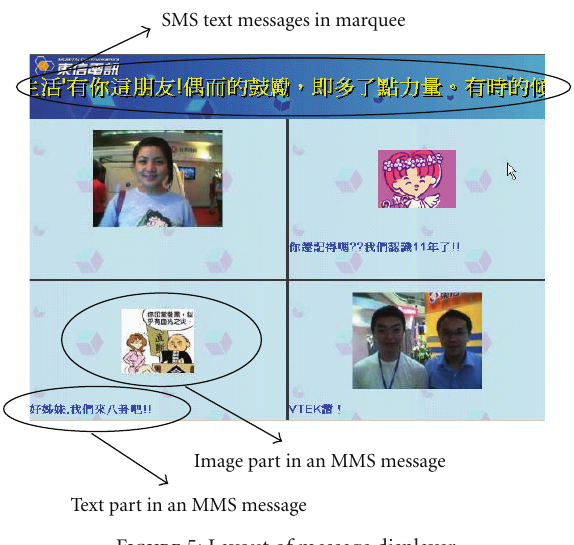
Figure 5: Layout of message displayer.